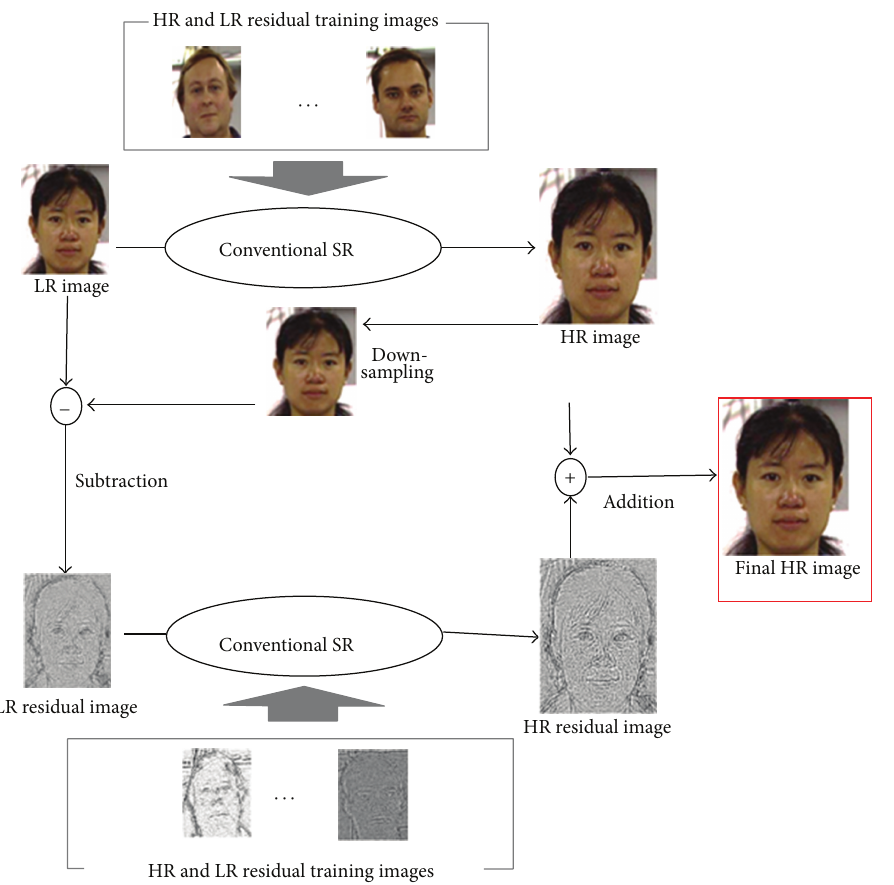
Figure 4: Proposed super resolution method